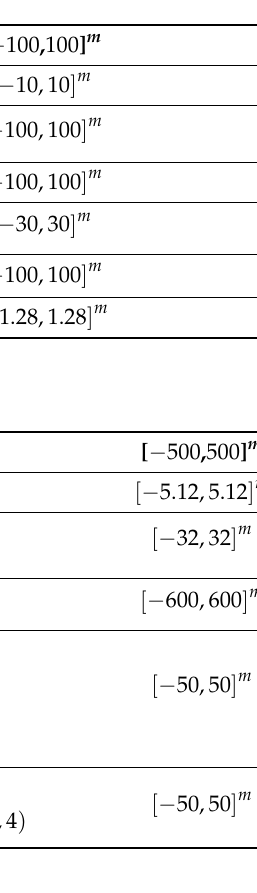
Table A1. Unimodal test functions.